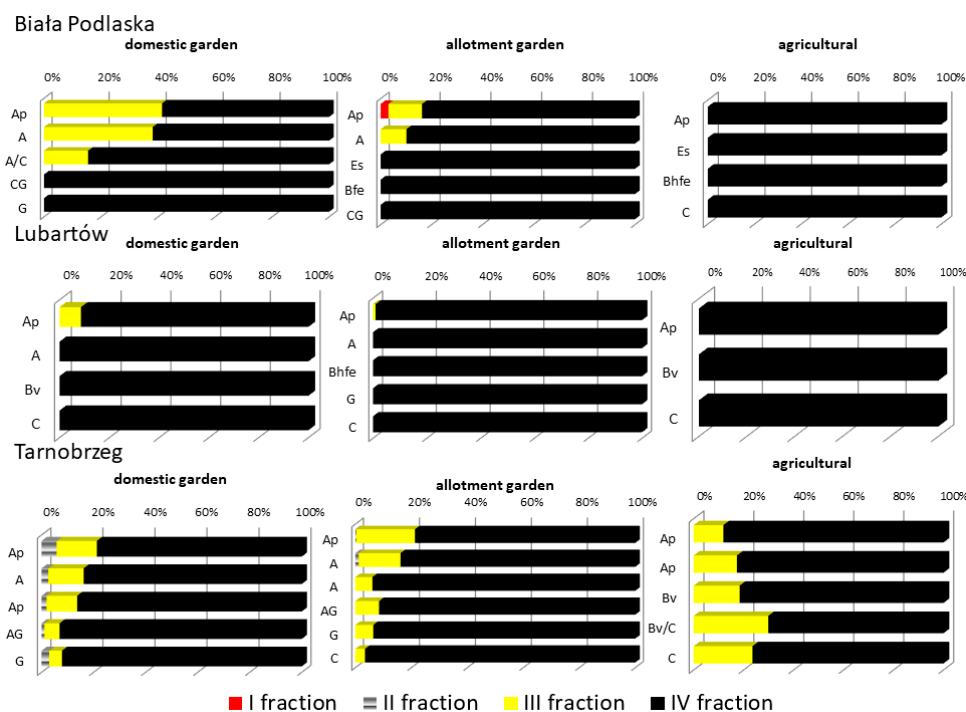
Figure 2. Percentage content of Cu fractions in sandy